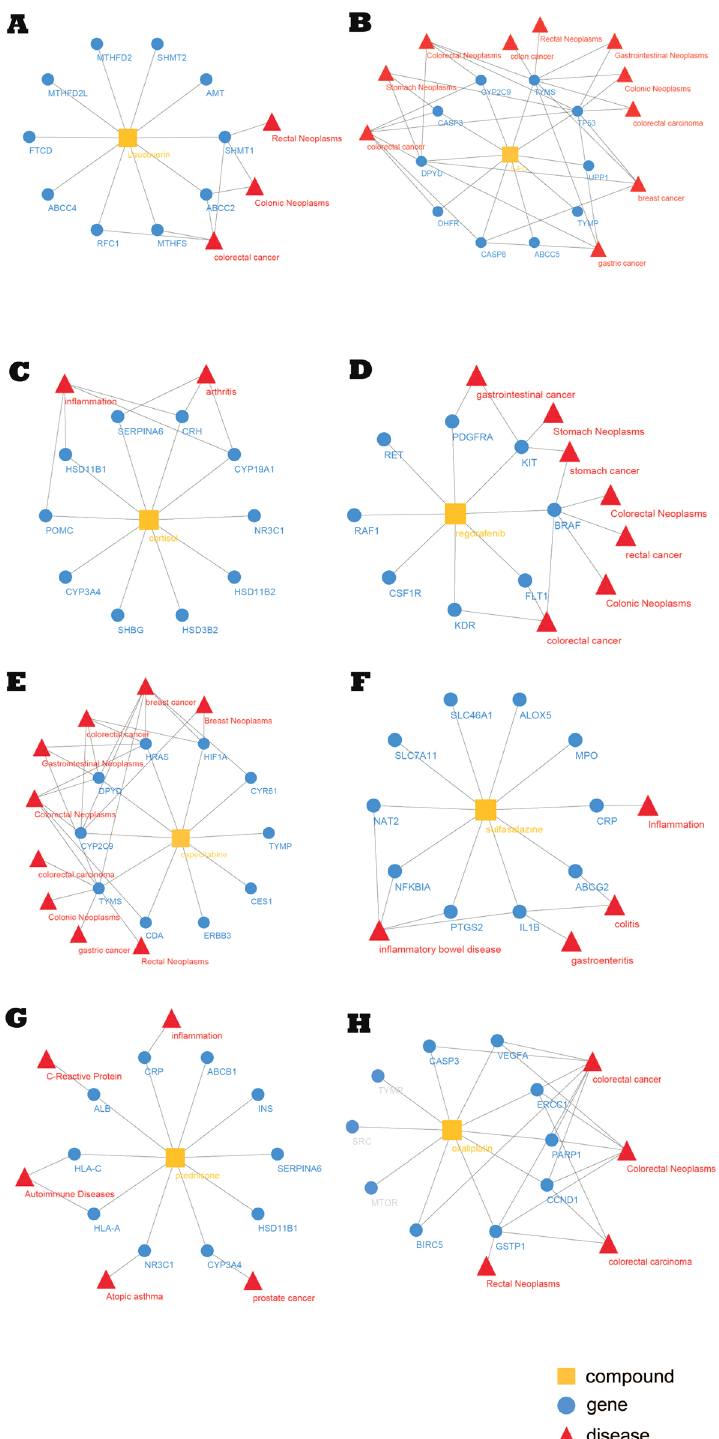
Figure 1. The network constructed for eight FDA approved drugs. ( A ) Leucovorin; ( B ) 5-fluorouracil; ( C ) Hydrocortisone; ( D ) Regorafenib; ( E ) Capecitabine; ( F ) Sulfasalazine; ( G ) Prednisone; ( H ) Oxaliplatin. The innermost node represented the drug, the circle in the middle represented the drug-related genes, the outermost layer represented the gene related diseases. Node: yellow square, compound; blue circle, gene; red triangle, disease. Line: the line between yellow square and blue circle, compound-gene links; the line between blue circle and red triangle, gene-disease